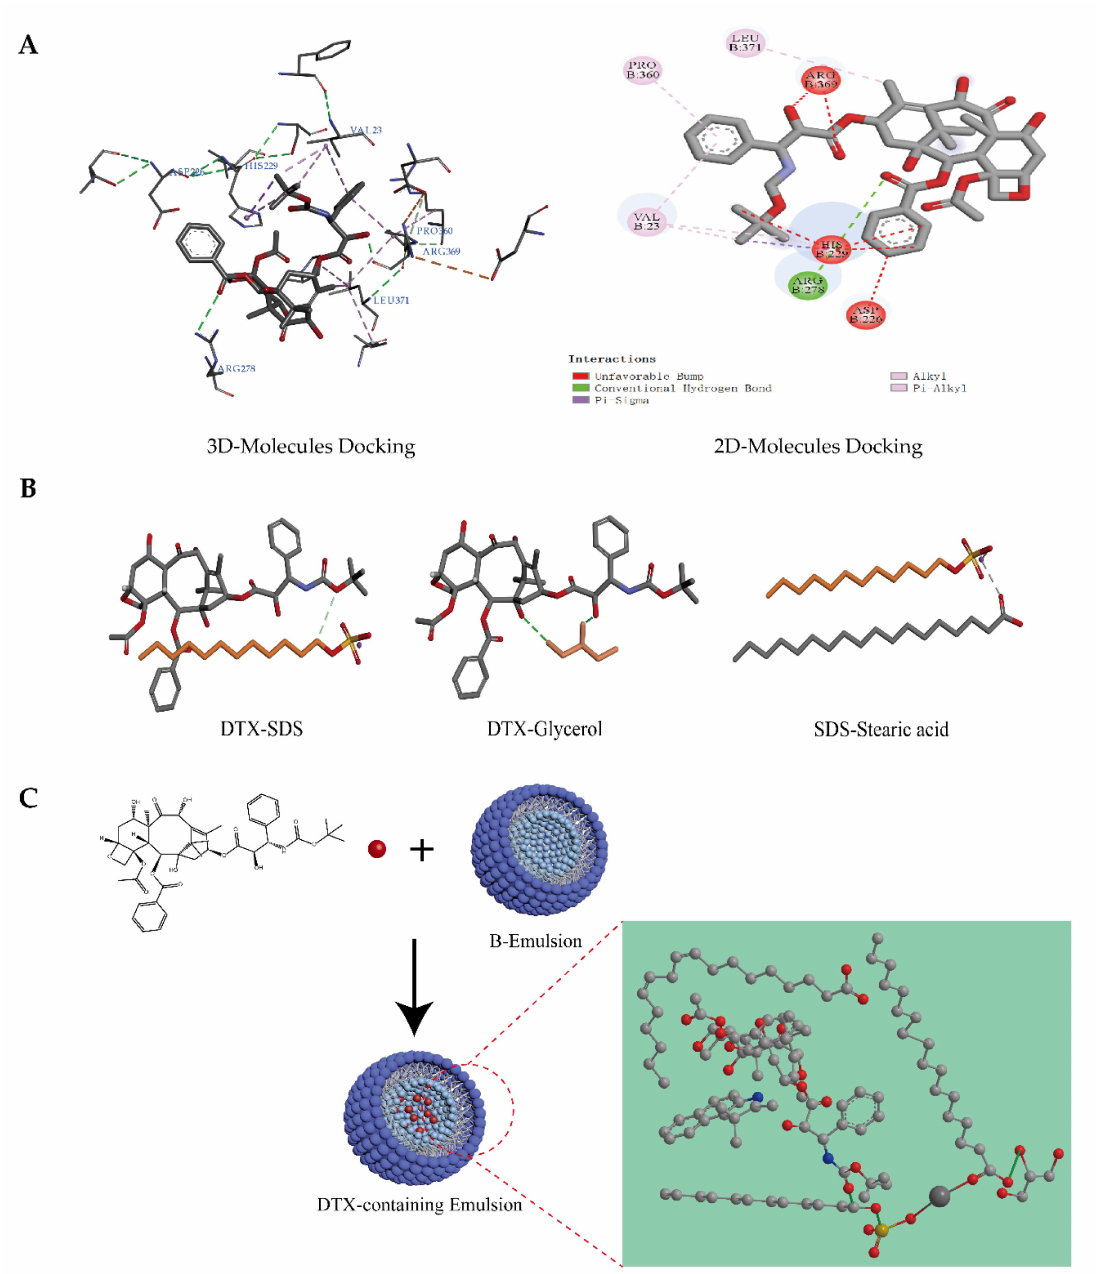
Figure 5. Prediction results by Discovery Studio 2016 software. ( A ) Three-dimensional and two- dimensional docking analysis binding β -tubulin (ID: 1TUB) with DTX. ( B ) Intermolecular docking analysis: DTX-Glycerol (hydrogen bond); DTX-SDS (hydrogen bond); SDS-Stearic acid (ionic bond). ( C ) Self-assembly layout and form of the micellar microparticles of DTX-containing